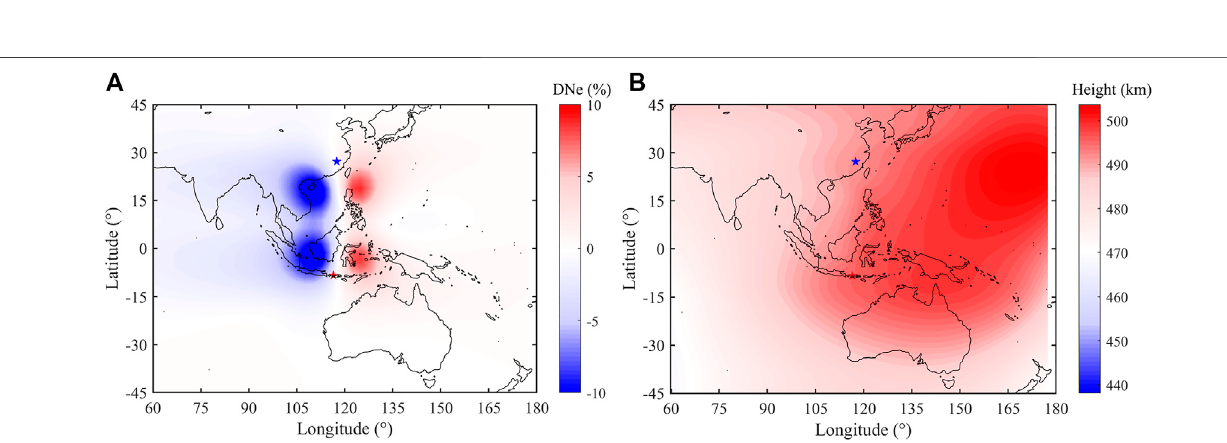
Frontiers in Earth Science |